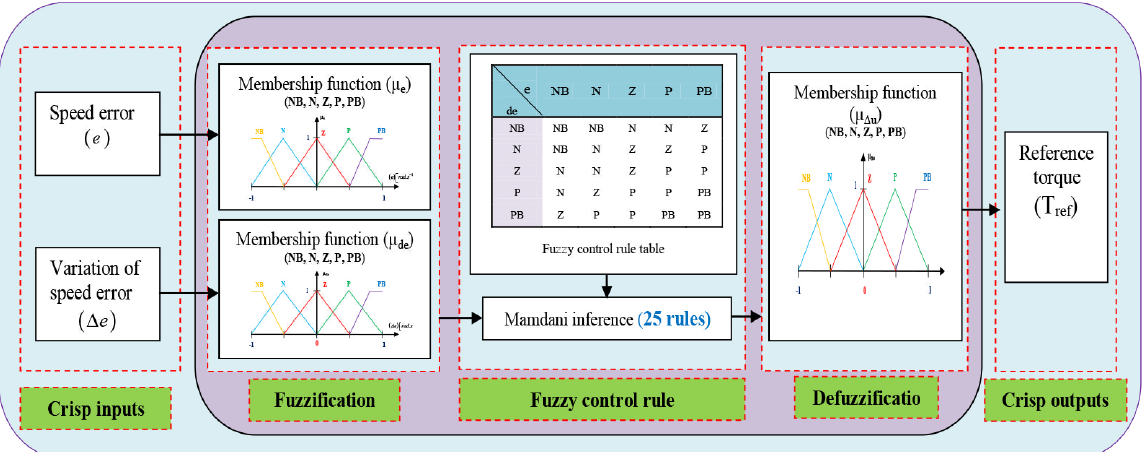
Figure 10. Principle of fuzzy speed controller.